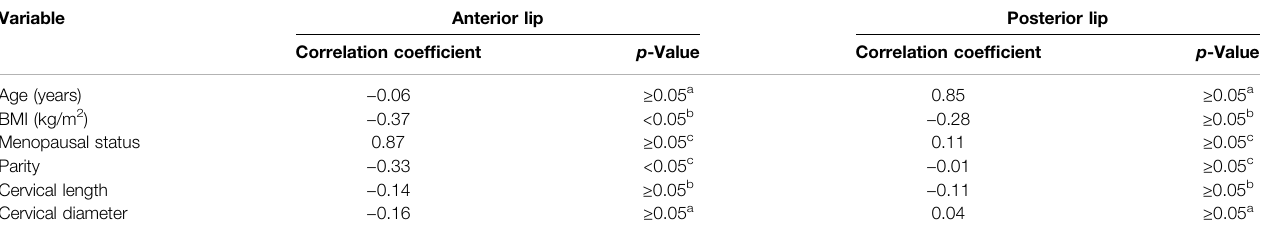
TABLE 4 | Analysis of factors affecting the depth of tissue